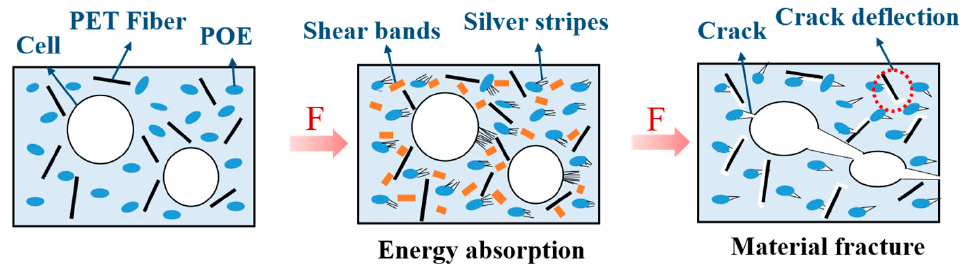
Figure 14. Schematic diagram of the crack toughening mechanism.